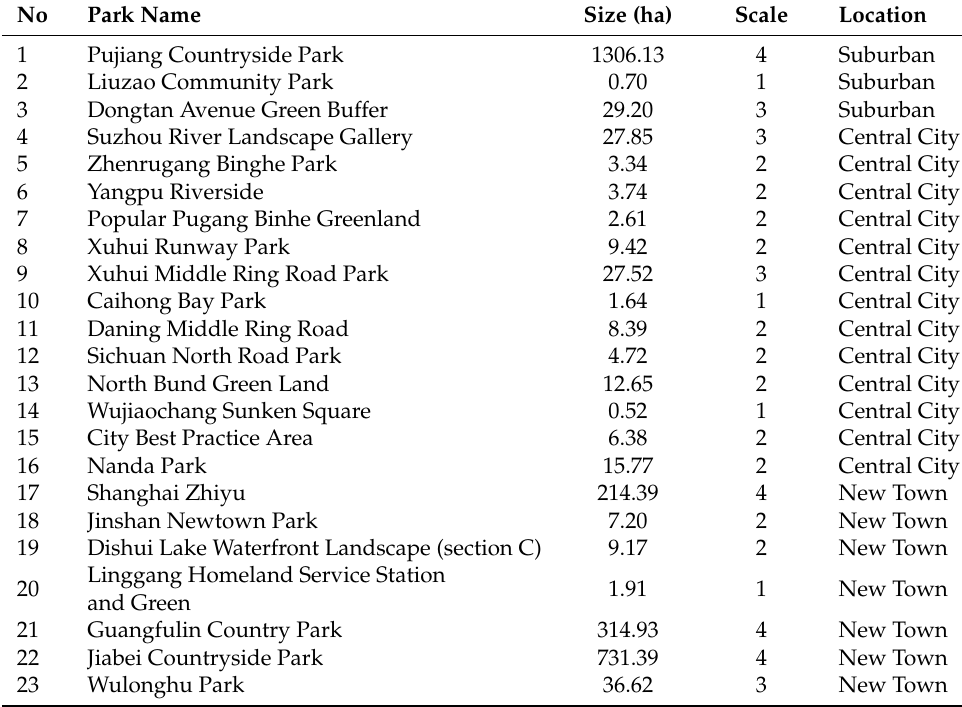
Table 3. The overview of the selected